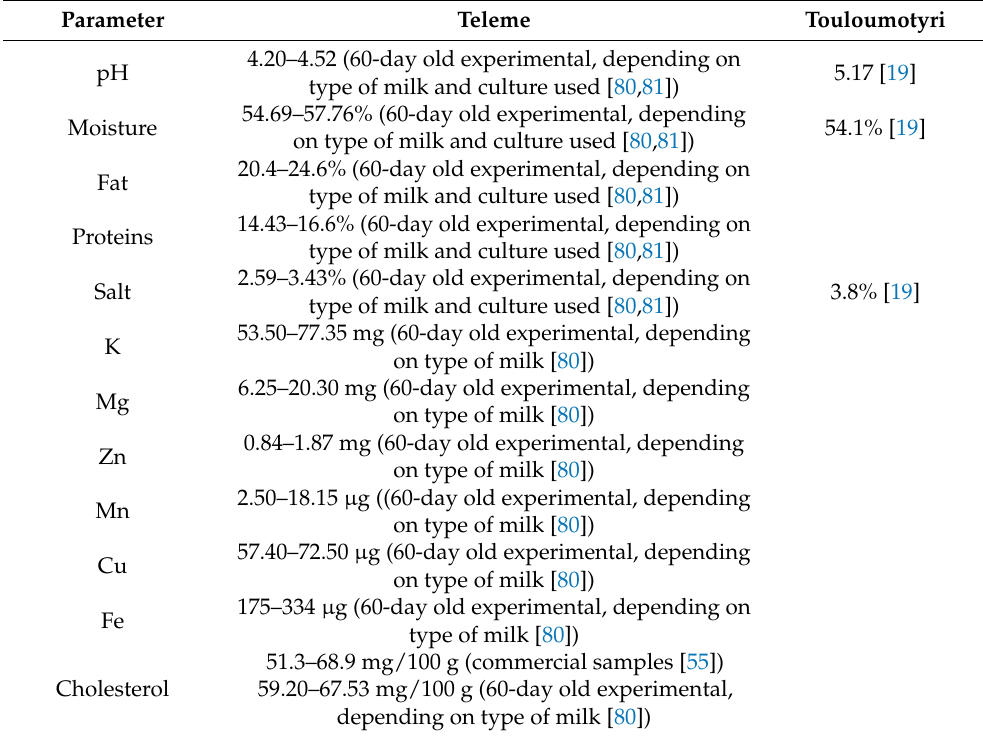
Table 8. Composition of nonprotected designation of origin and nonprotected geographical indication soft